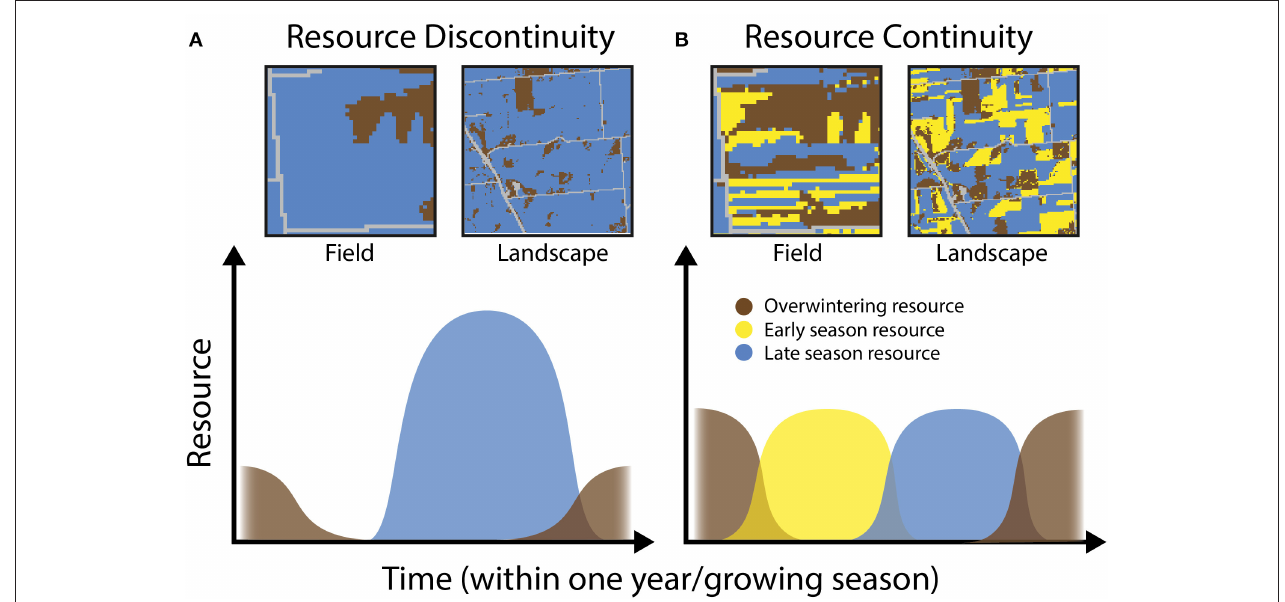
FIGURE 1 | Conceptual representation of how resources may vary through time in heterogeneous agroecosystems. (A) Depicts hypothetical low-continuity scenarios in a single farm field or an entire agricultural landscape. In these scenarios, natural enemy populations are limited by overwintering habitat and experience a resource gap in the early season. (B) Depicts high-continuity scenarios where enemies have sufficient resources available at all